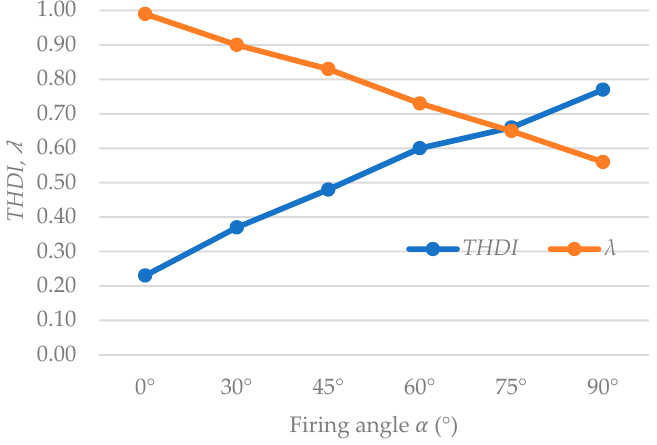
Figure 18. Chart of total harmonic distortion of the phase current THDI and power factor λ for all firing angles 𝛼 .